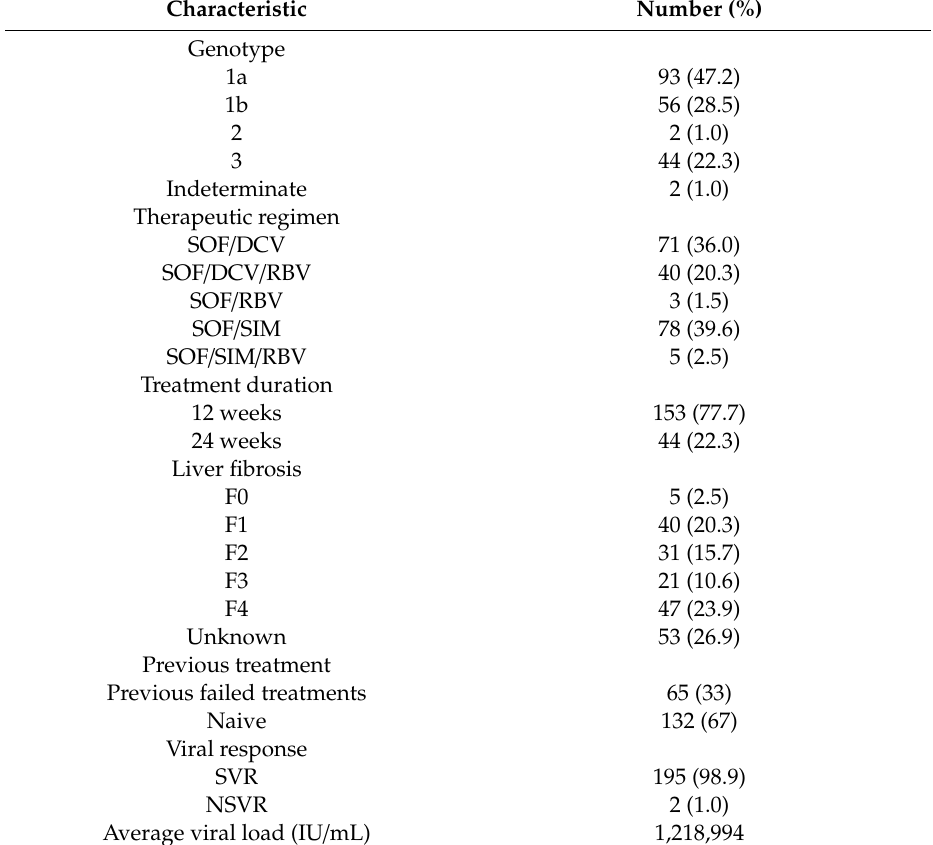
Table 1. Baseline clinical and demographic characteristics of patients with chronic hepatitis C ( n = 197).